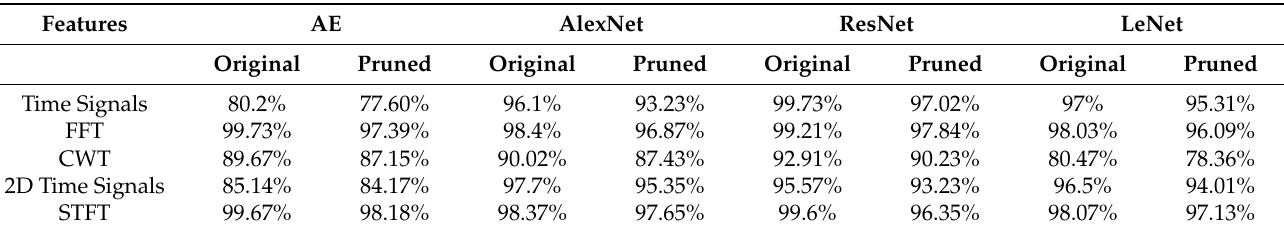
Table 6. Comparison of accuracy for original and pruned model.